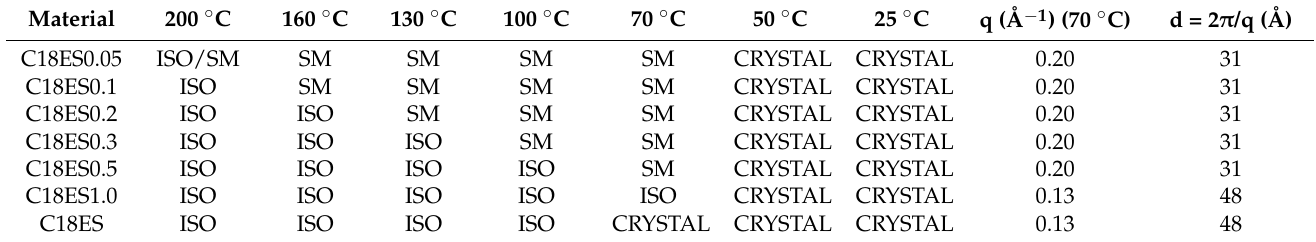
Table 3. Summarized phases (ISO = isotropic, SM = smectic, and CRYSTAL = crystalline) of blended electrolytes containing C18ES as shown through SAXS and WAXS measurements at each measure- ment temperature while cooling. Values of the scattering vector for the first major peaks and the corresponding d-spacing values at 70 ◦ C are also shown.